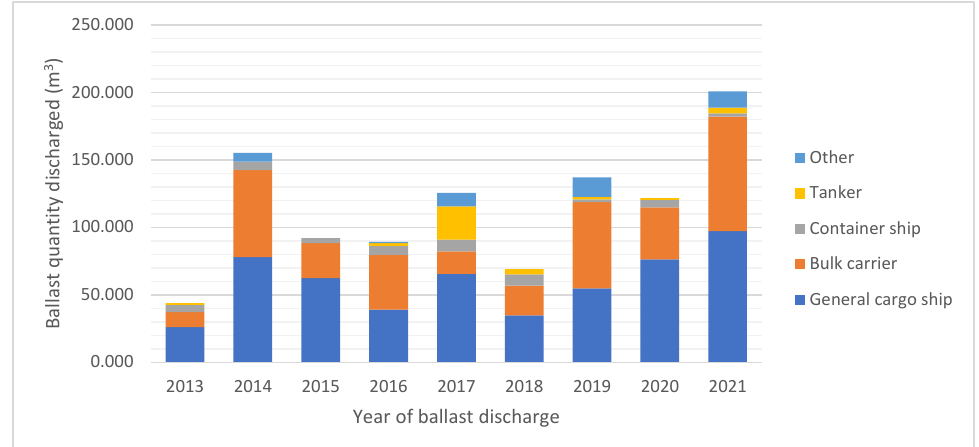
Figure A2. BW quantities discharged in the Port of Ploče by month.